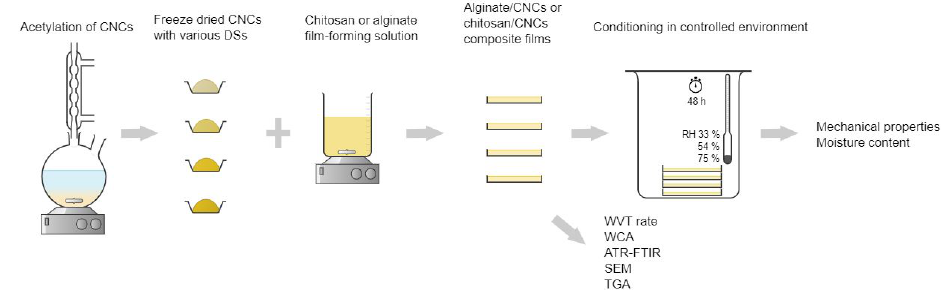
Figure 1. Schematic representation of the